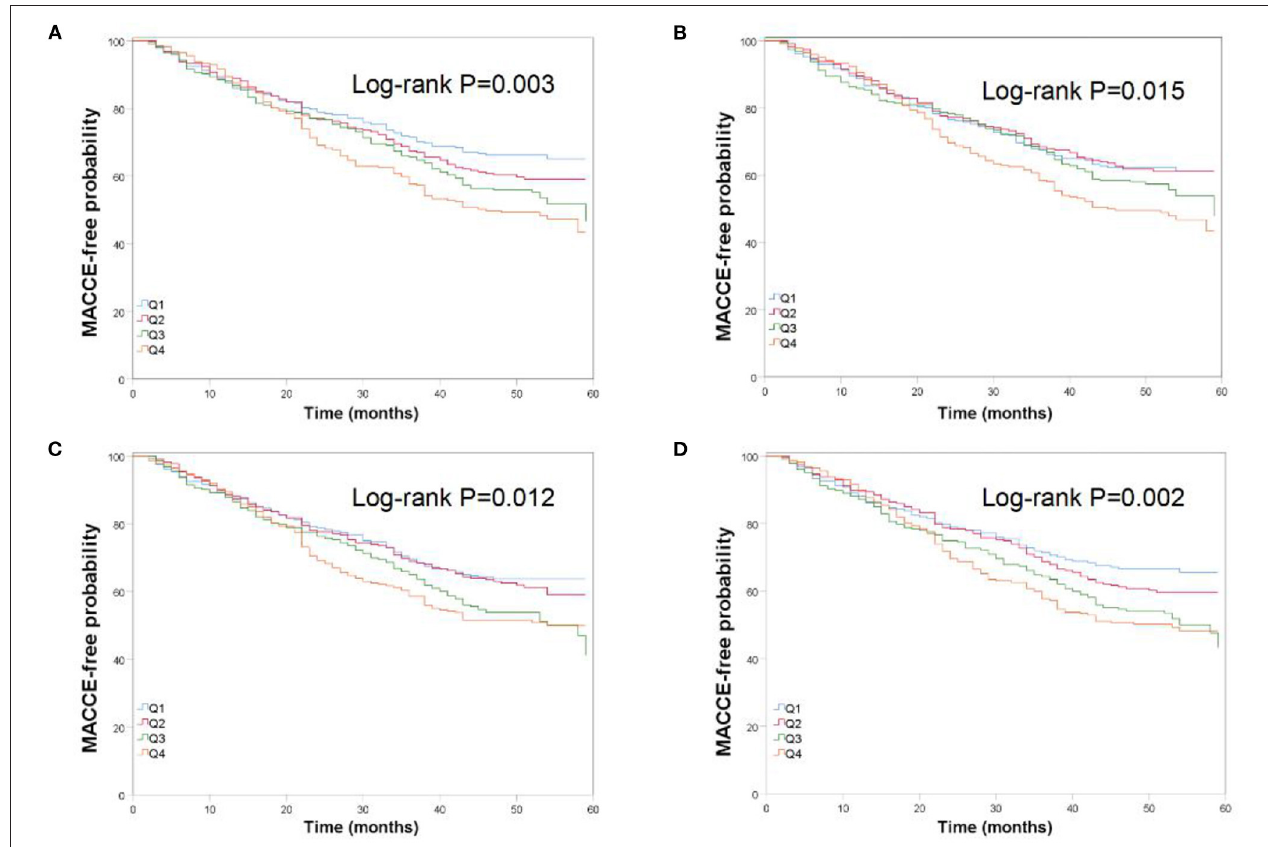
FIGURE 1 | Kaplan-Meier estimates of MACCE-free probability by quartiles of total cholesterol variability measured as four indices: (A) K-M curve by CV; (B) K-M curve by SD; (C) K-M curve by ASV; (D) K-M curve by